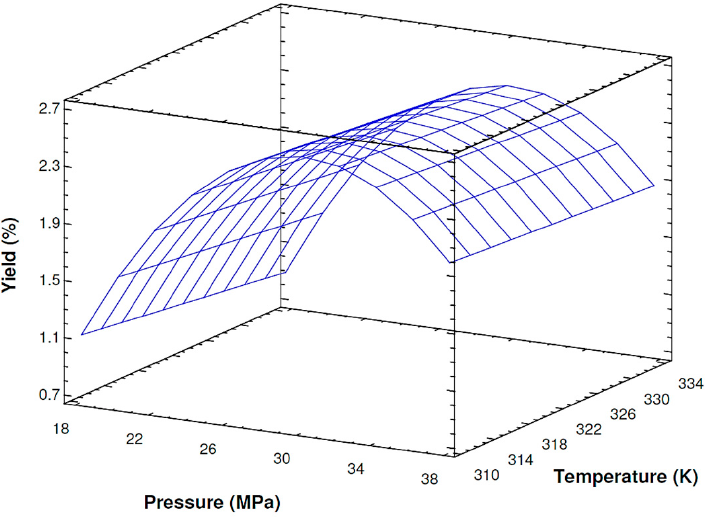
Figure 2. Response surface for extraction process over extraction yield.